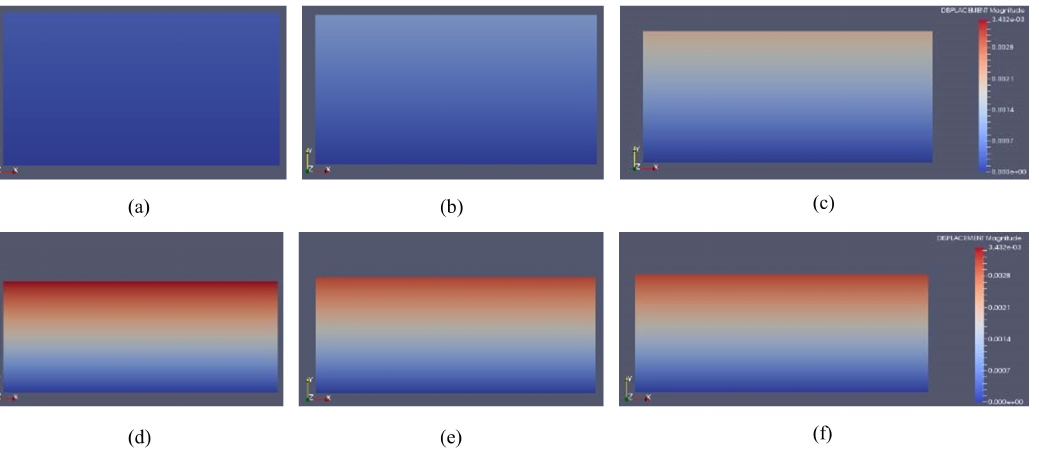
Figure 7. Displacement contour of SO-01 at ( a ) 0.5 MPa, ( b ) 2.5 MPa, ( c ) 10 MPa, and ( d ) 50 MPa in compression, and ( e ) 25 MPa and ( f ) 0.5 MPa in recovery.